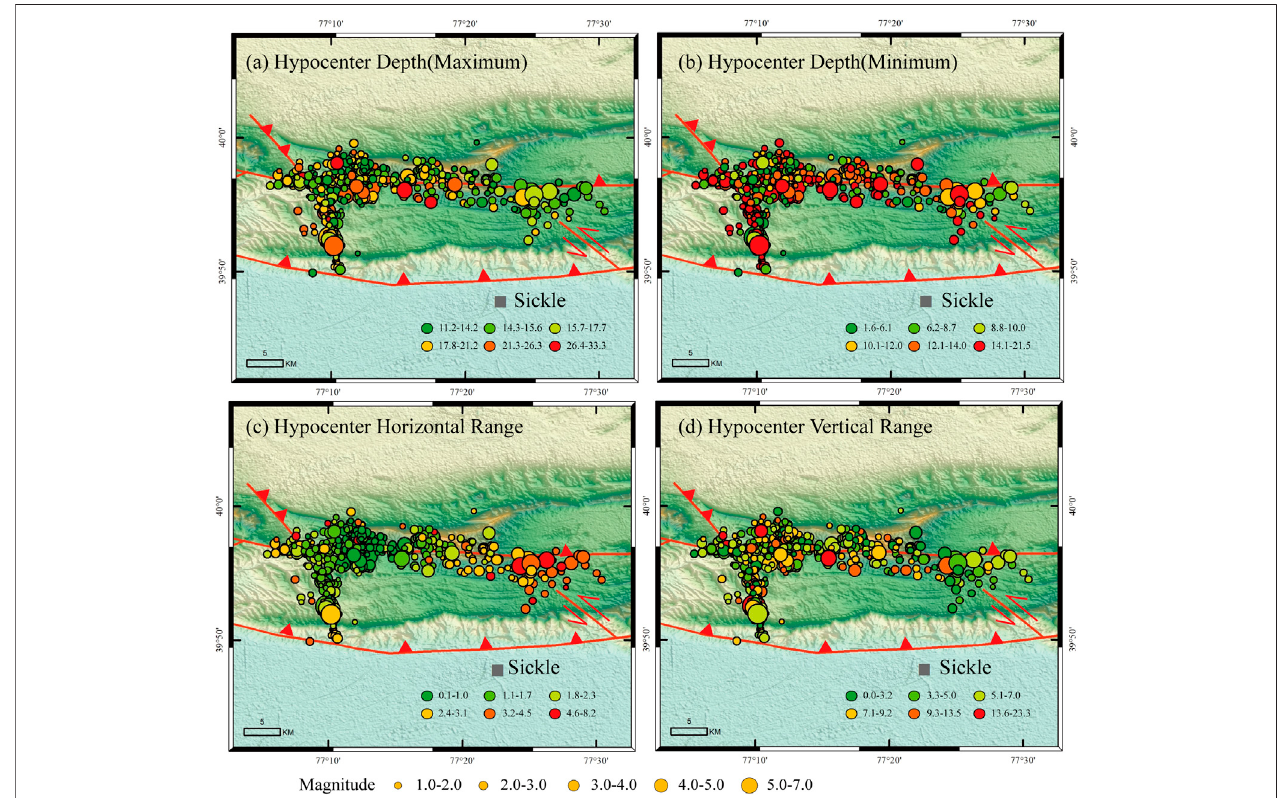
FIGURE 8 | Distribution of the relocated aftershock epicenters using the eight velocity models. The sizes of the circles represent the magnitude, and the color shows the variations in the depth and ranges. (A) Maximum depths. (B) Minimum depths. (C) Horizontal ranges. (D) Vertical ranges.